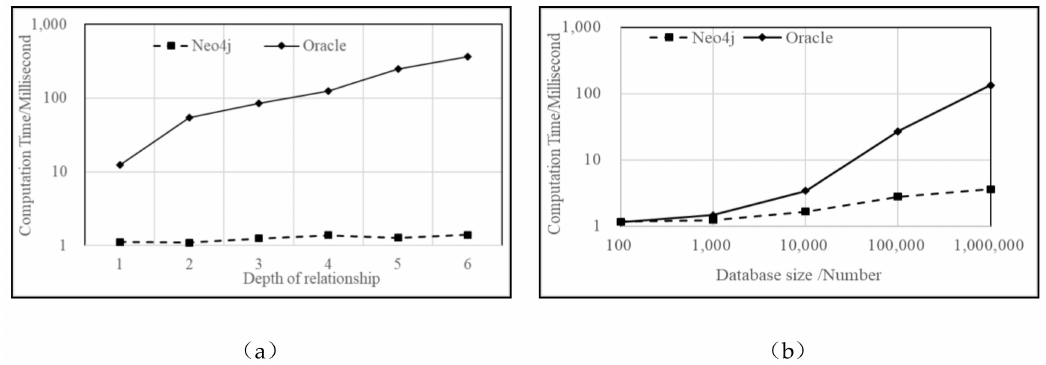
Figure 13. Comparisons of the querying evolution